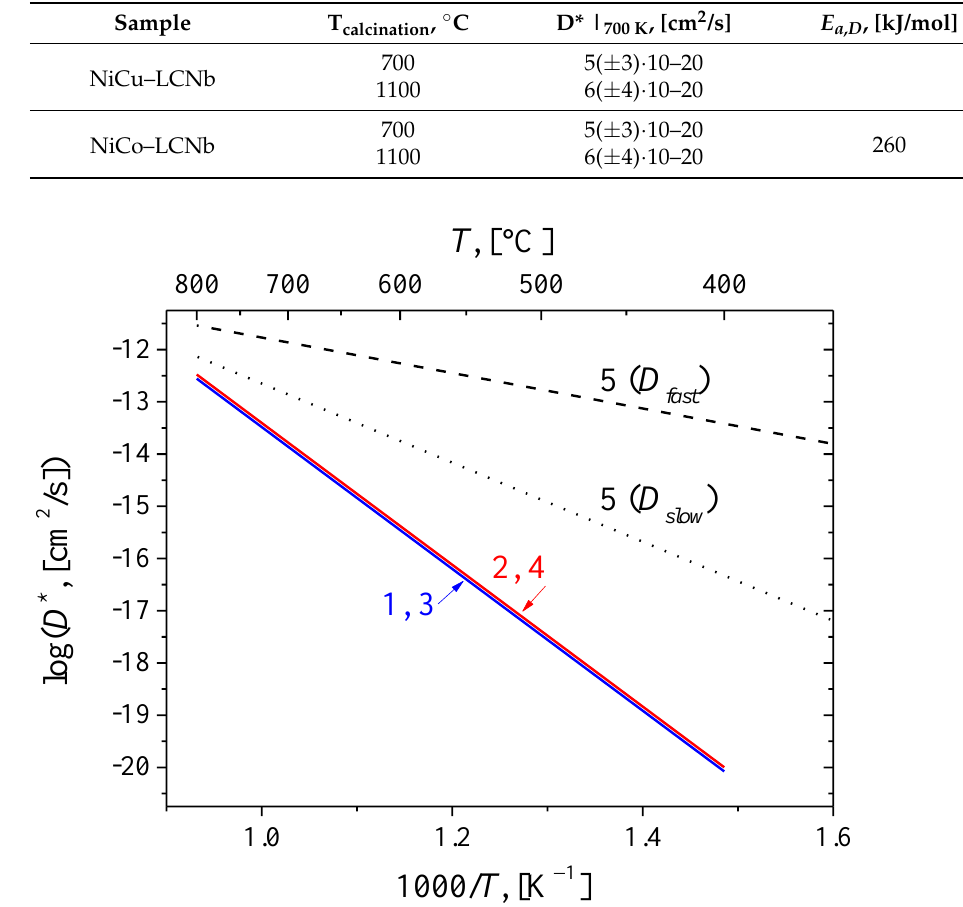
Table 3. The oxygen tracer diffusion coefficient values at 700 K and its effective activation energy for NiCu – LCNb and NiCo – LCNb samples according to TPIE with C 18 O 2 data modelling.